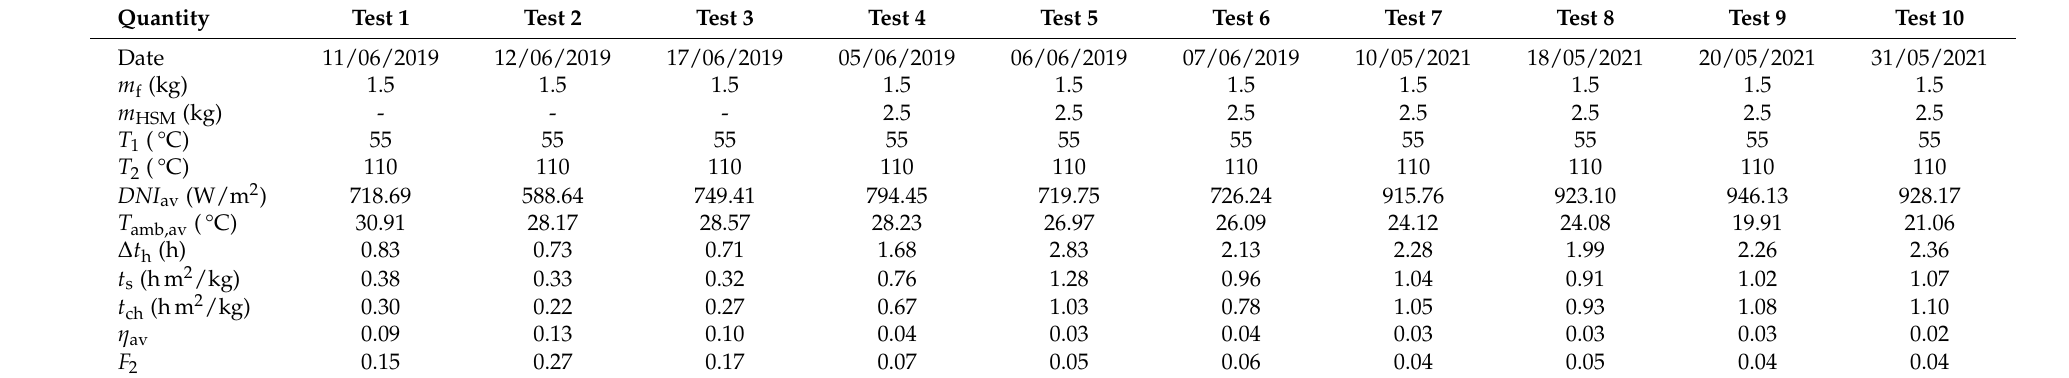
Table 6. Summary of the tests carried out with silicone oil and silicone oil + HSM during the heating phase.